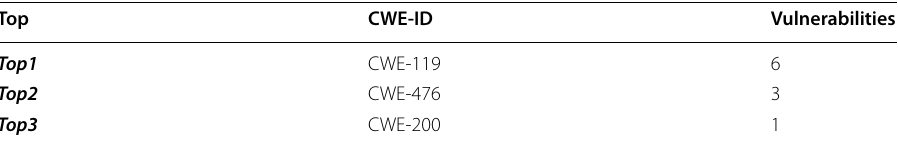
Table 4 Types of vulnerabilities fixed by VulRep